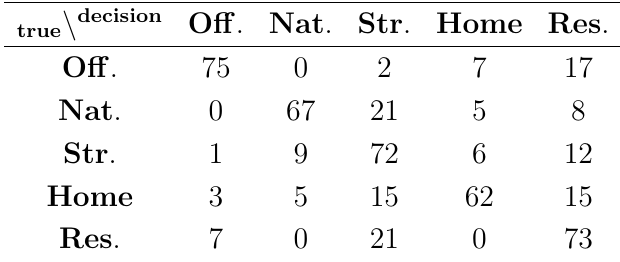
Table 7. Confusion matrix of five environment classes office , nature , street/road , home and restaurant/pub/cafe using MAP classifier. The values denote percentages.